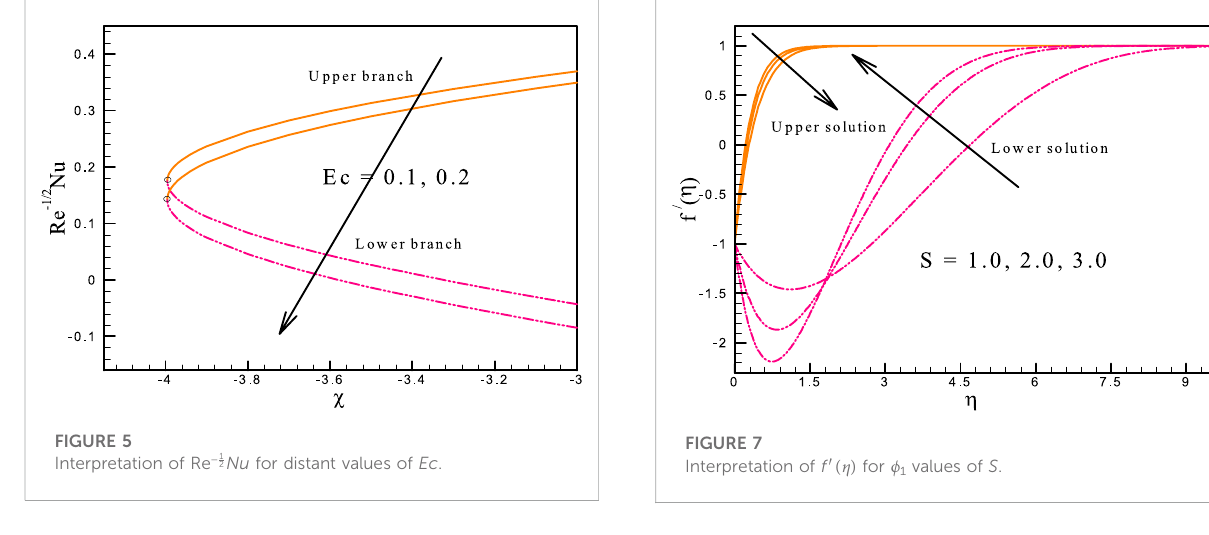
FIGURE 5 Interpretation of Re − 1 2 Nu for distant values of Ec .